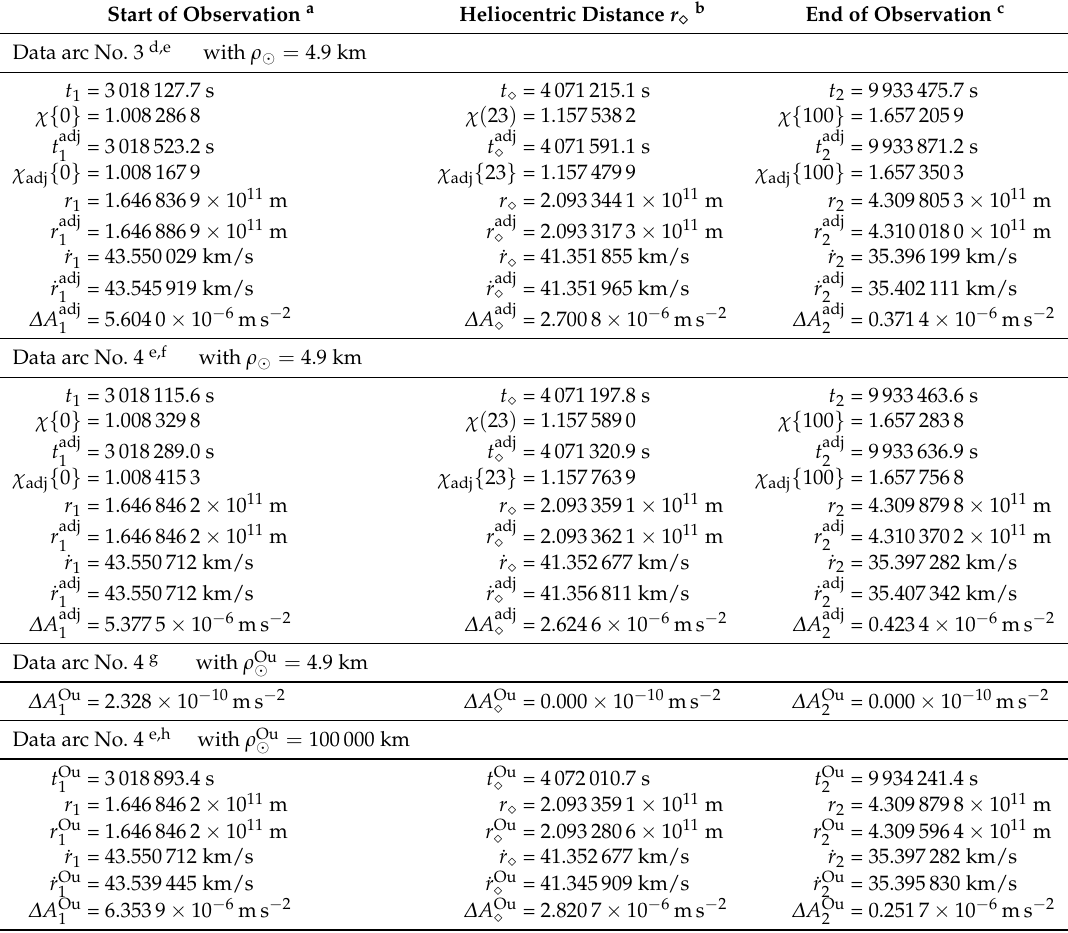
Table 3. Boundaries of the trajectory calculations and anomalous acceleration